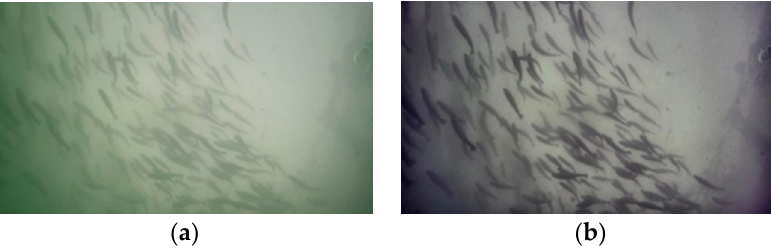
Figure 2. Image contrast before and after enhancement: ( a ) original image and ( b ) enhanced image.